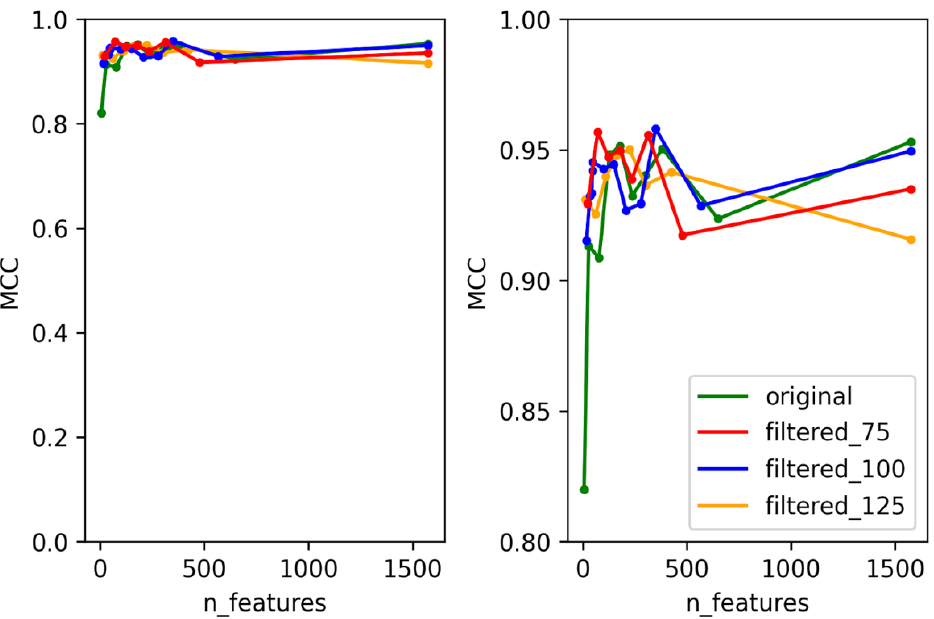
Figure 2. Test MCC of integrase predictor using original dataset and filtered datasets using different numbers of features. Graph on the right shows the magnified section of the original graph with MCC ranging from 0.8 to 1.